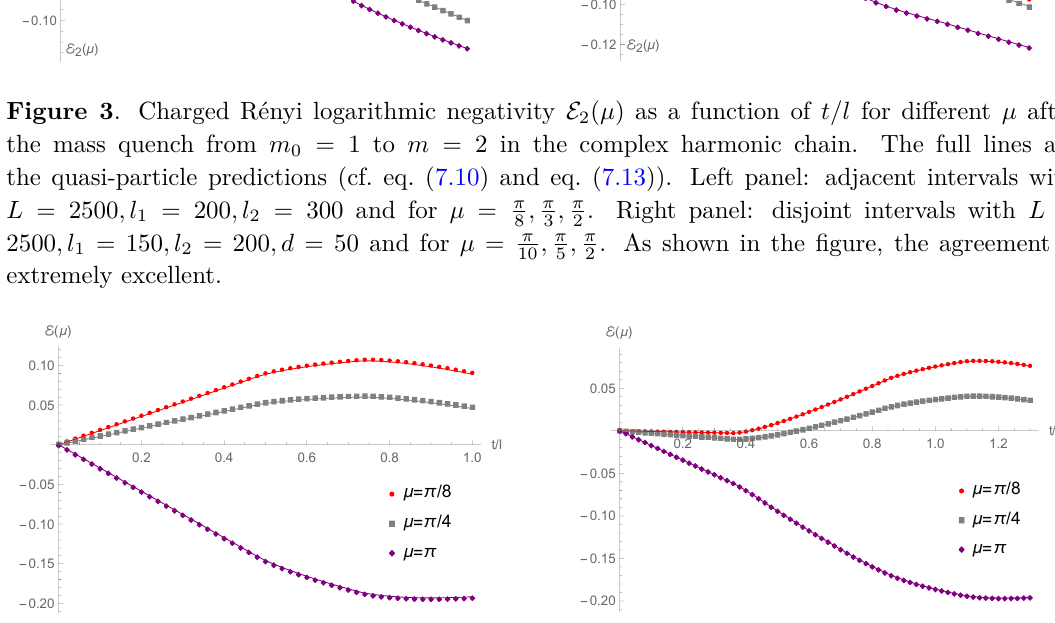
Figure 4 . Charged logarithmic negativity E ( µ ) as a function of t/l for different µ after the mass quench from m 0 = 1 to m = 2 in the complex harmonic chain. The full lines are the quasi-particle predictions (cf. eq. (7.11) and eq. (7.14)). Left panel: adjacent intervals with L = 2500 , l 1 = 200 , l 2 = 300 and for µ = π , π , π . Right panel: disjoint intervals with L = 2500 , l 1 = 200 , l 2 = 8 4 300 , d = 150 and for µ = π , π , π . As shown in the figure, the agreement is perfect. 8 4 Disjoint